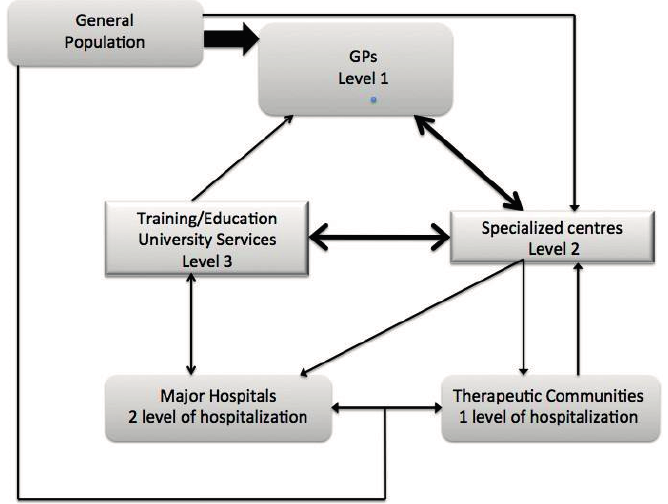
Figure 1. New organization in treating AUD